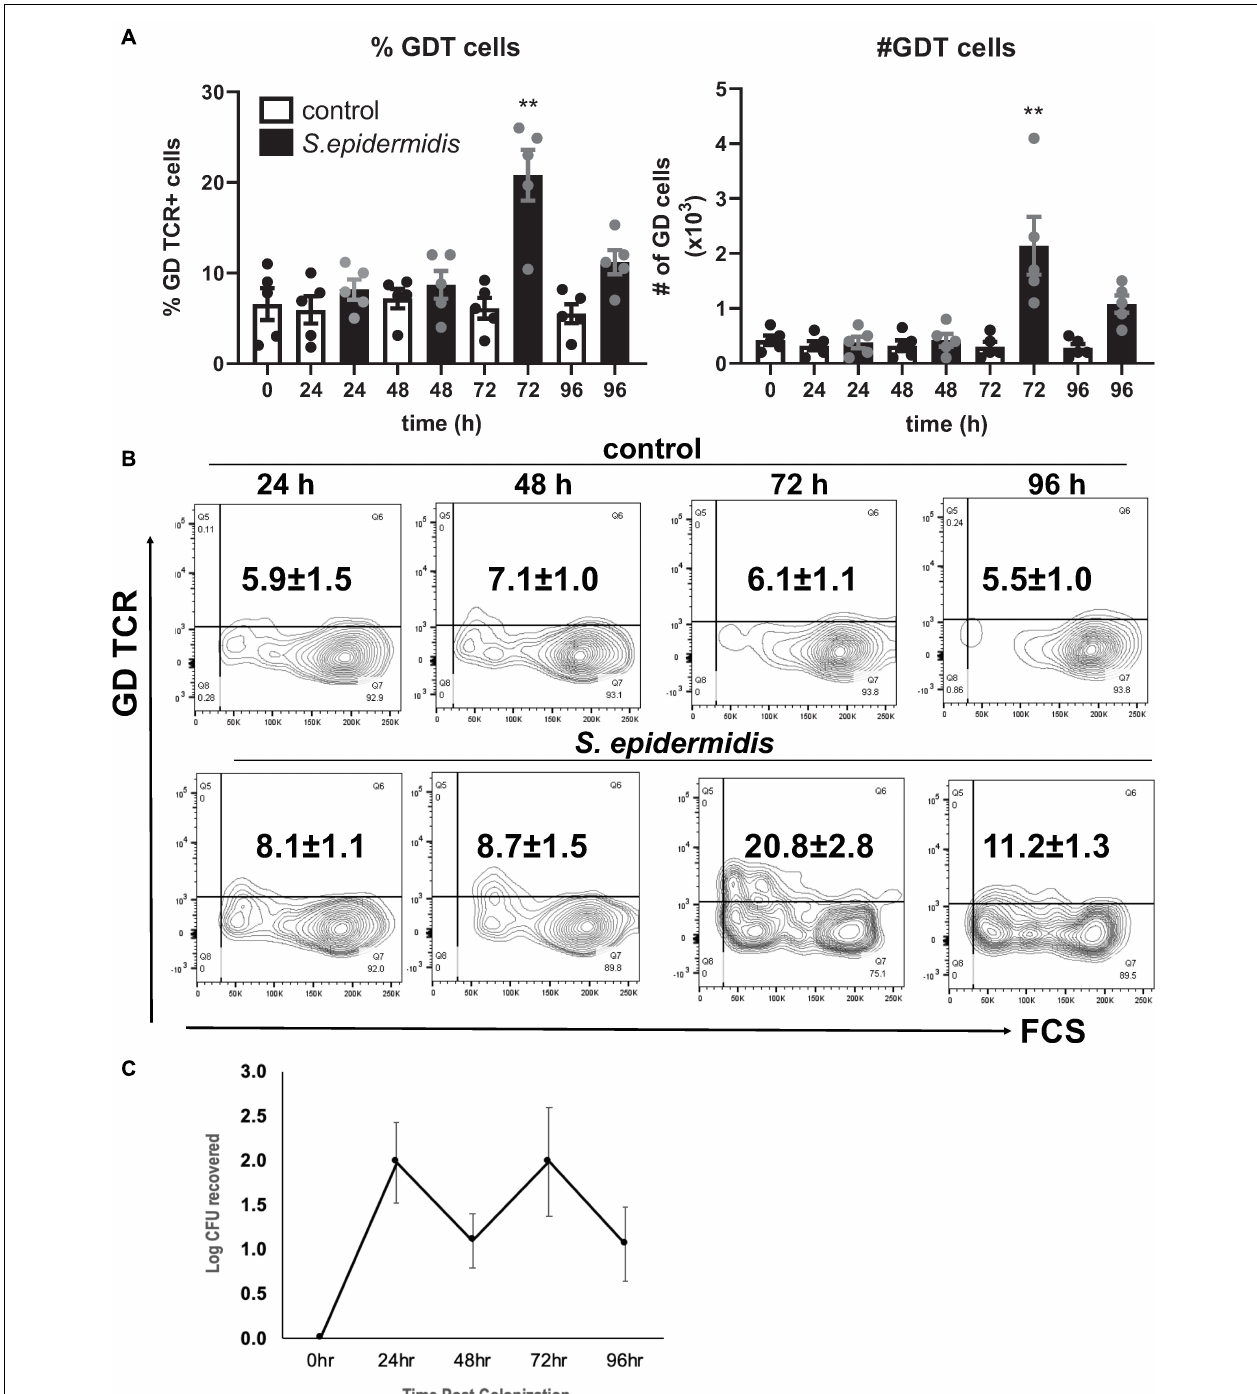
FIGURE 1 | Staphylococcus epidermidis increases the number of GD T cells in human skin ex vivo . Control, uncolonized, and S. epidermidis colonized skin was maintained on air liquid interface and collected at indicated time points (0, 24, 48, 72, and 96 h). Single cell suspensions were obtained and labeled with live/dead stain, CD45, CD3, and GD TCR. (A) Cells were analyzed using flow cytometry and gated on the CD45 + CD3 + GDT + population. Bar graphs show SEM frequency (%) and SEM number (#) of skin GD T cells ( n = 5). (B) Representative contour plots showing frequency of GD TCR in control and S. epidermidis colonized skin. (C) Number of S. epidermidis colony forming units (CFU) recovered from ex vivo skin explants colonized with S. epidermidis CCN021 on day 0 through day 4. Data represent at least two technical replicates and five independent biological replicates per group. ** p < 0.01 (two-way ANOVA with Holm-Sidak multiple-comparison